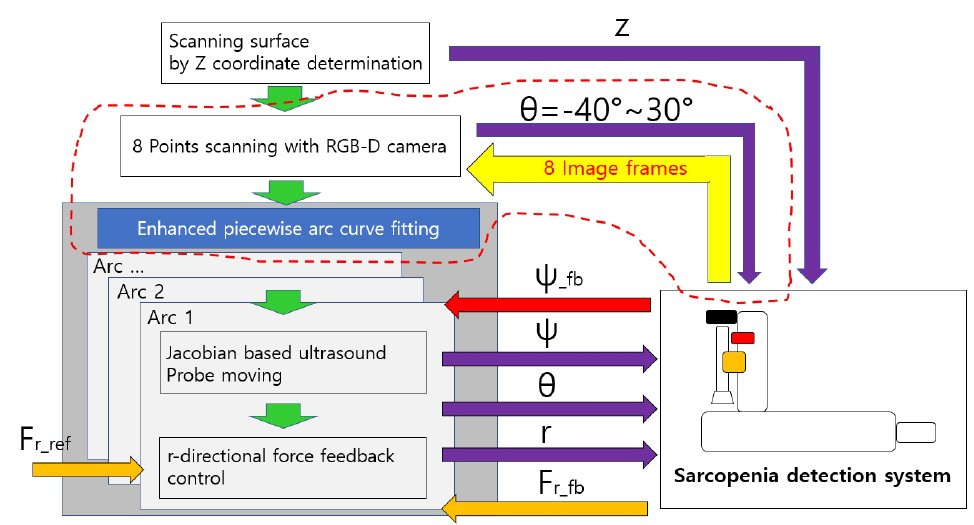
Figure 2. The modified overall control flow diagram (the parts modified from previous work [26] are surrounded by the red dotted line).